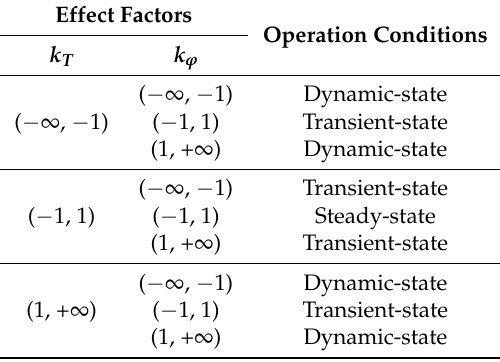
Table 3. Effect factors for different operation